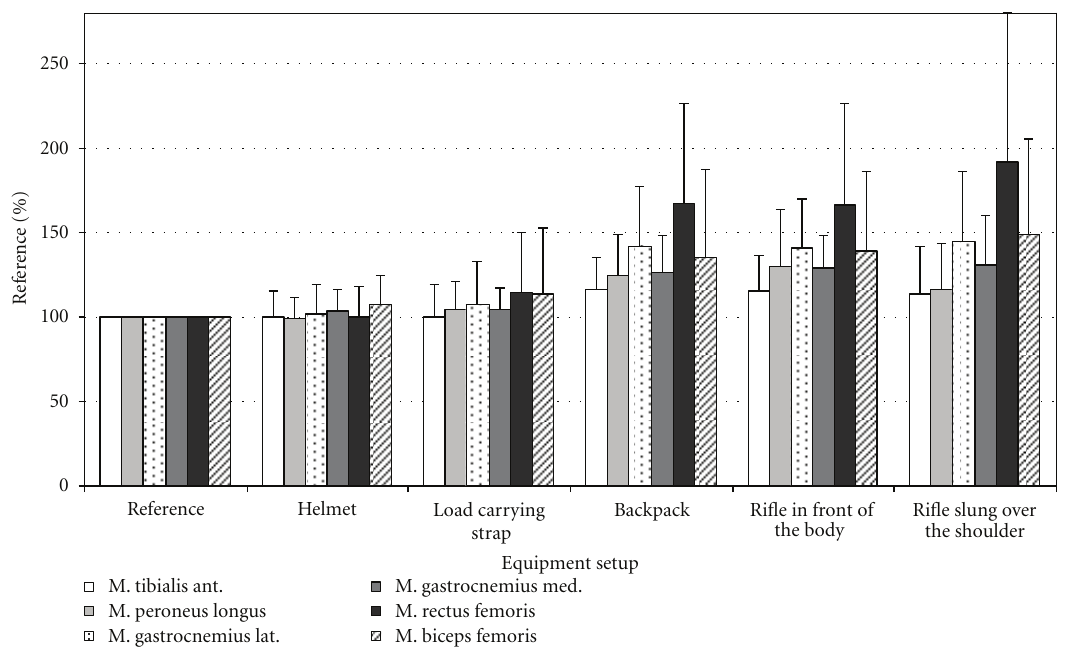
Figure 3: Peak EMG in percent compared to the peak EMG values of the reference